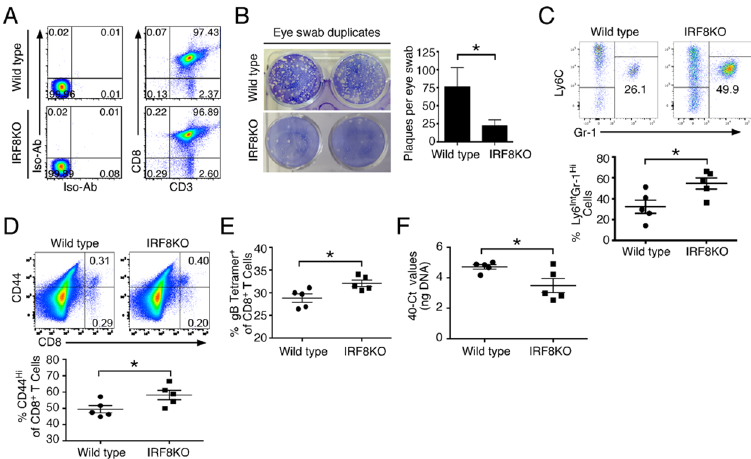
Fig 6. Adoptive transfer of CD8 + deficient T cells reduced viral load and enhanced viral-induced inflammation in HSV-1-infected mice. (A) CD8 + T cells from WT or IRF8 KO mice were MACS sorted and 10 x 10 6 cells were transferred into CD8 α KO mice. After 1 day, mice were ocularly infected with 2 x 10 5 pfu of HSV-1 via scarification. (B) On day 6 p.i., eye swabs were taken and infectious virus was assessed by plaque assay in duplicates (N = 20). Bars represent the mean pfu ± SEM of virus per cornea. Significance was determined by Mann-Whitney U test. (C-F) Mice were then sacrificed on day 8 p.i. (C) Corneas were harvested, digested with collagenase and inflammatory cells recruited to the cornea were assessed by flow cytometry. Bars represent the mean frequency ± SEM of Ly6C Int Gr-1 hi neutrophils from the CD11b + gate. Flow plots represent the quantity of cells within the cornea. (D & E) Draining lymph nodes were harvested and activated CD8 + T cells (D) and virus-specific (gB-positive) CD8 + T cells (E) were analyzed. The cells were gated on CD8 + population and numbers in the quadrants of the FACS plot represent the frequency of CD44 hi cells while bars on the graphs represent the mean frequency ± SEM of CD44 hi or gB-tetramer specific CD8 +